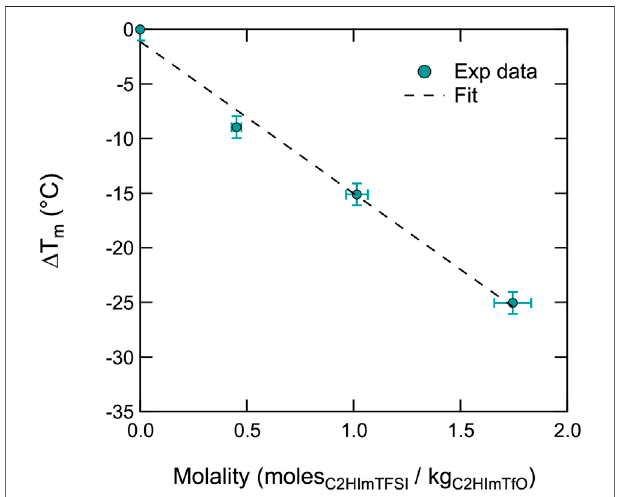
FIGURE 4 | Depression of the melting temperature Tm (of [C2HIm][TfO]) as a function of composition (given in molality).